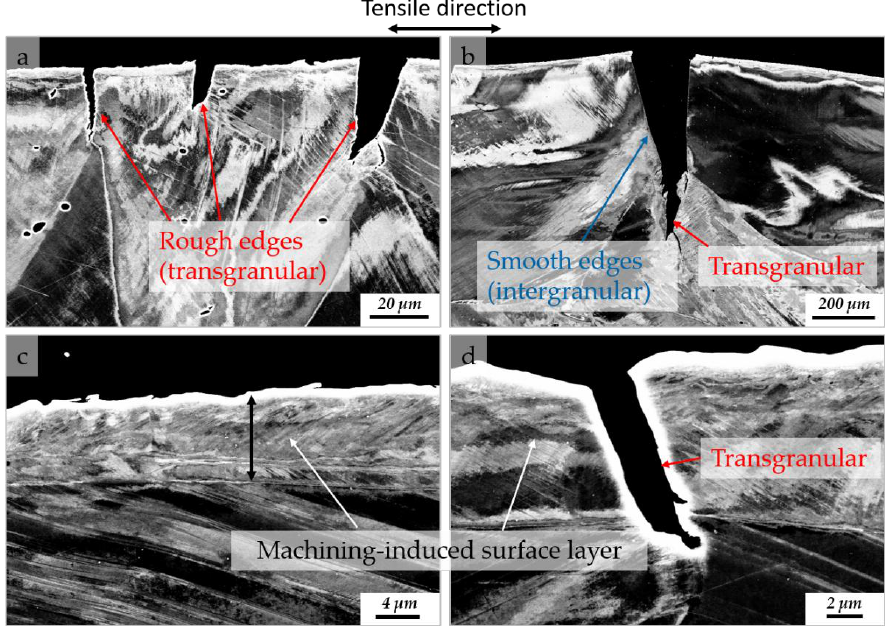
Figure 7. ECCI micrographs taken from regions near the surface of the tensile-tested HM specimen; ( a ) transgranular cracks; ( b ) crack mode transition from intergranular to transgranular; ( c ) magnified view of the machining-induced surface layer; ( d ) magnified view of a transgranular crack in the machining-induced surface layer.